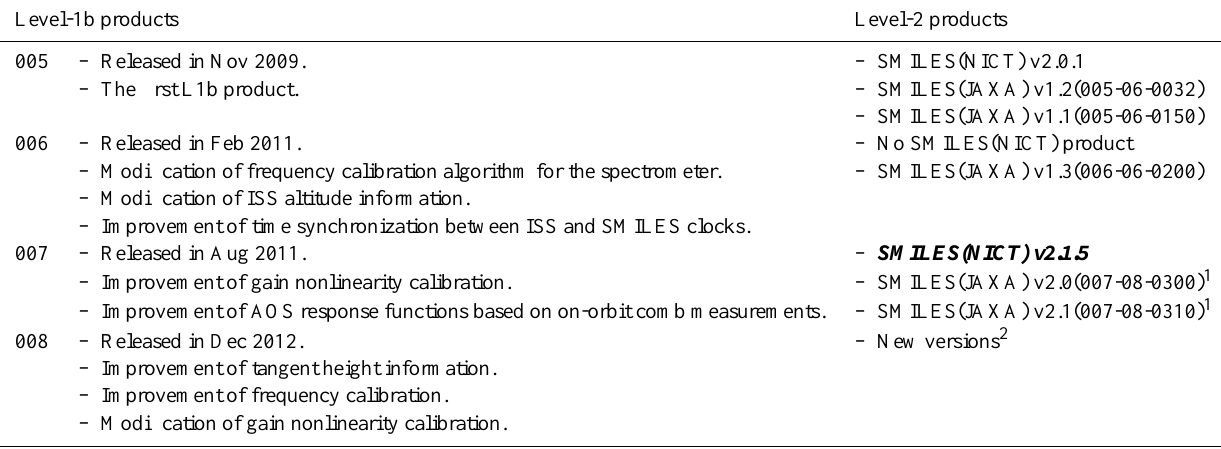
Table 2. Summary of the SMILES L1b products and associated L2 products. Two L2 processing chains from NICT and JAXA are denoted as SMILES(NICT) and SMILES(JAXA), respectively. The data product described in this paper is shown in bold